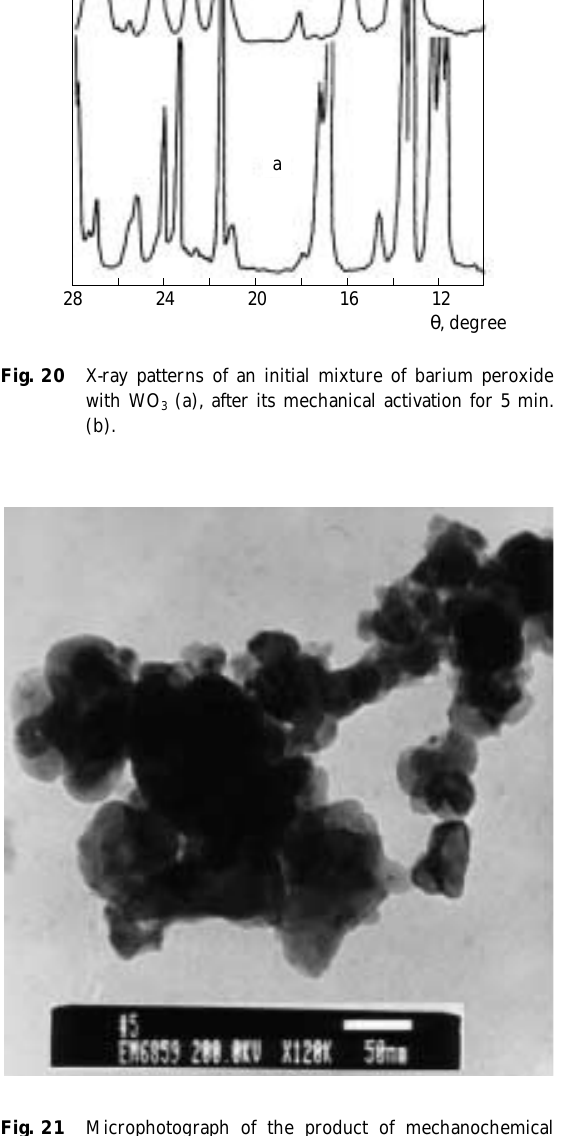
Fig. 21 Microphotograph of the product of mechanochemical interaction of BaO 2 (cid:4) WO 3 (time of MA 5